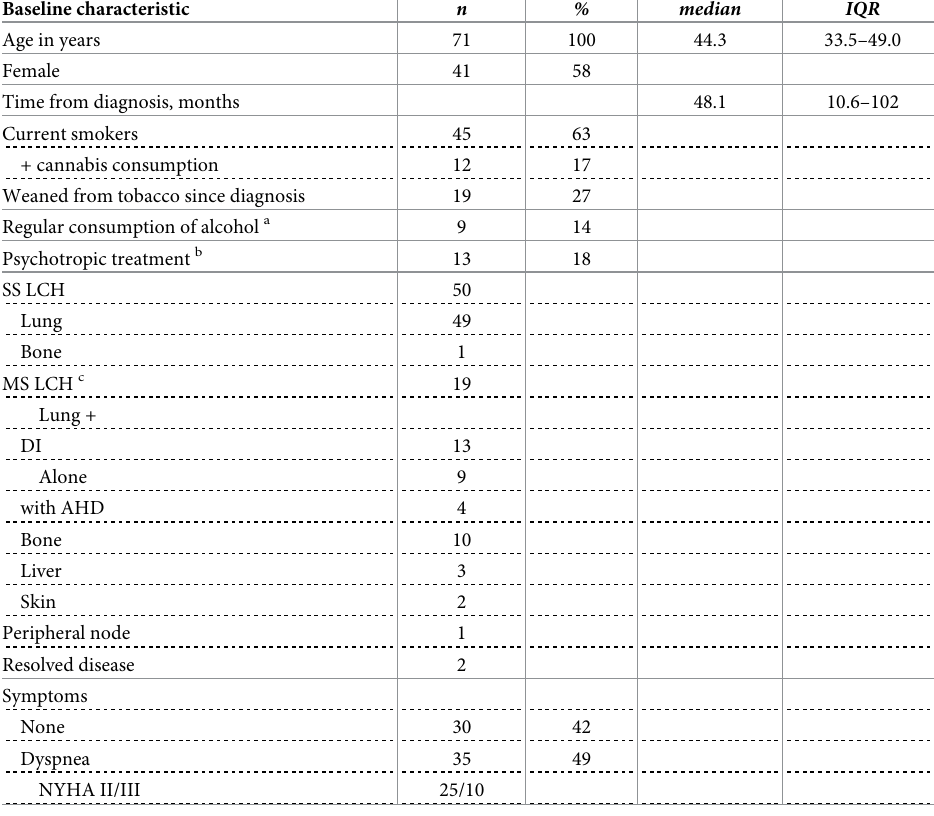
Table 1. Characteristics of the LCH patients at the time of inclusion in the